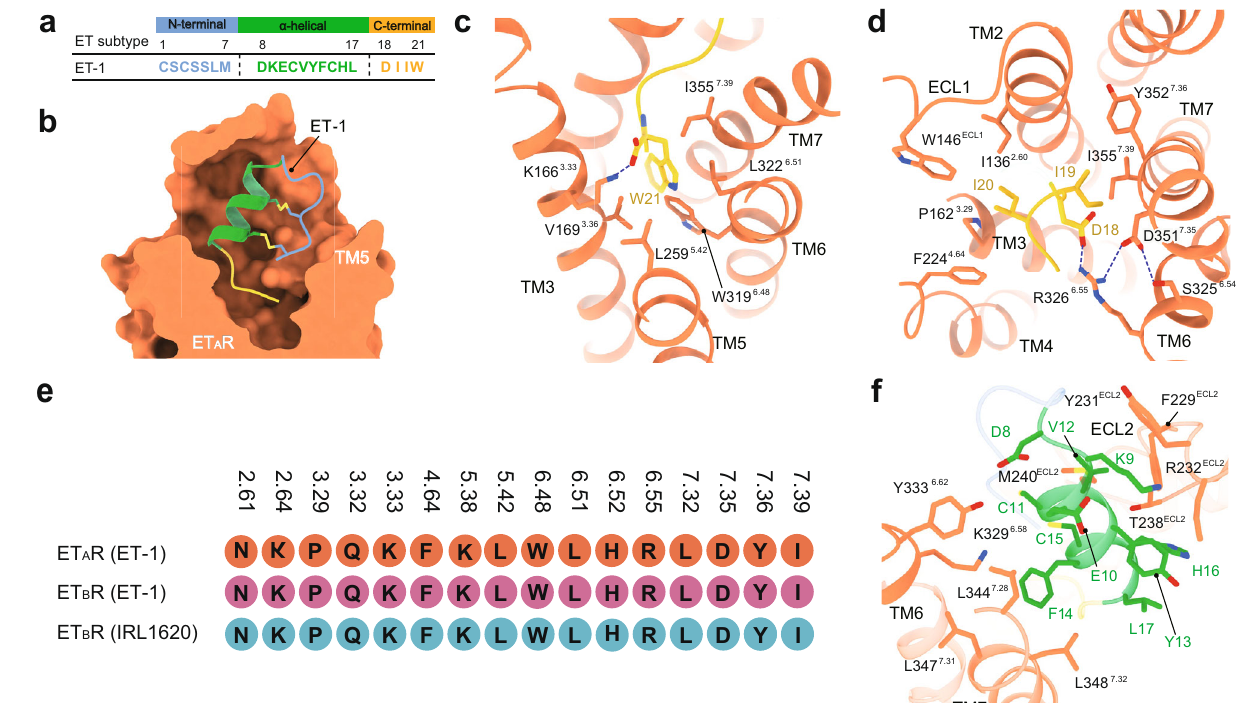
Fig.3|RecognitionofET-1byET A R.a SequenceofET-1.TheN-terminal, α -helical, and C-terminal regions of ET-1 are colored blue, green, and yellow, respectively. b Cross-section of the ET-1-binding pocket in ET A R. Two pairs of intramolecular disul fi debondsofET-1aredisplayedassticks.ET-1isshownasaribbonmodelwith